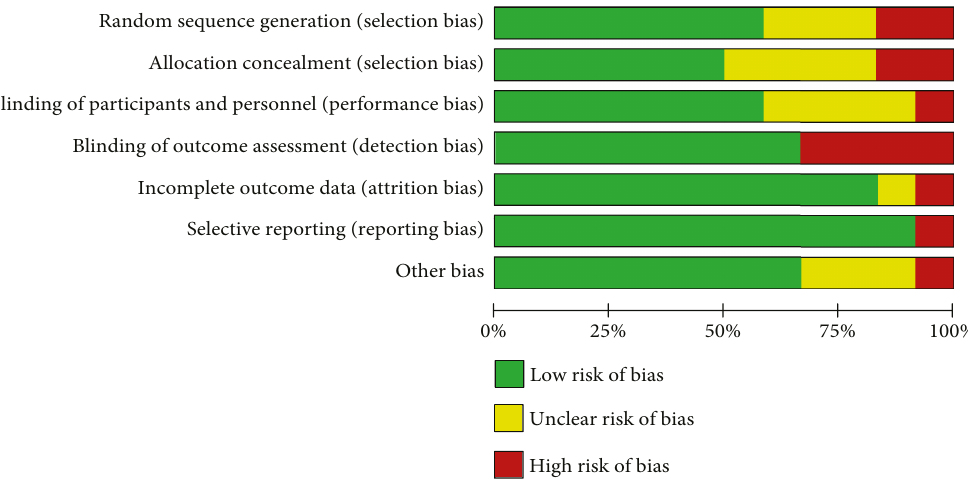
Figure 1: Risk of bias graph: a review of authors ’ judgments about each “ risk of bias ” item presented as percentages across all included studies.